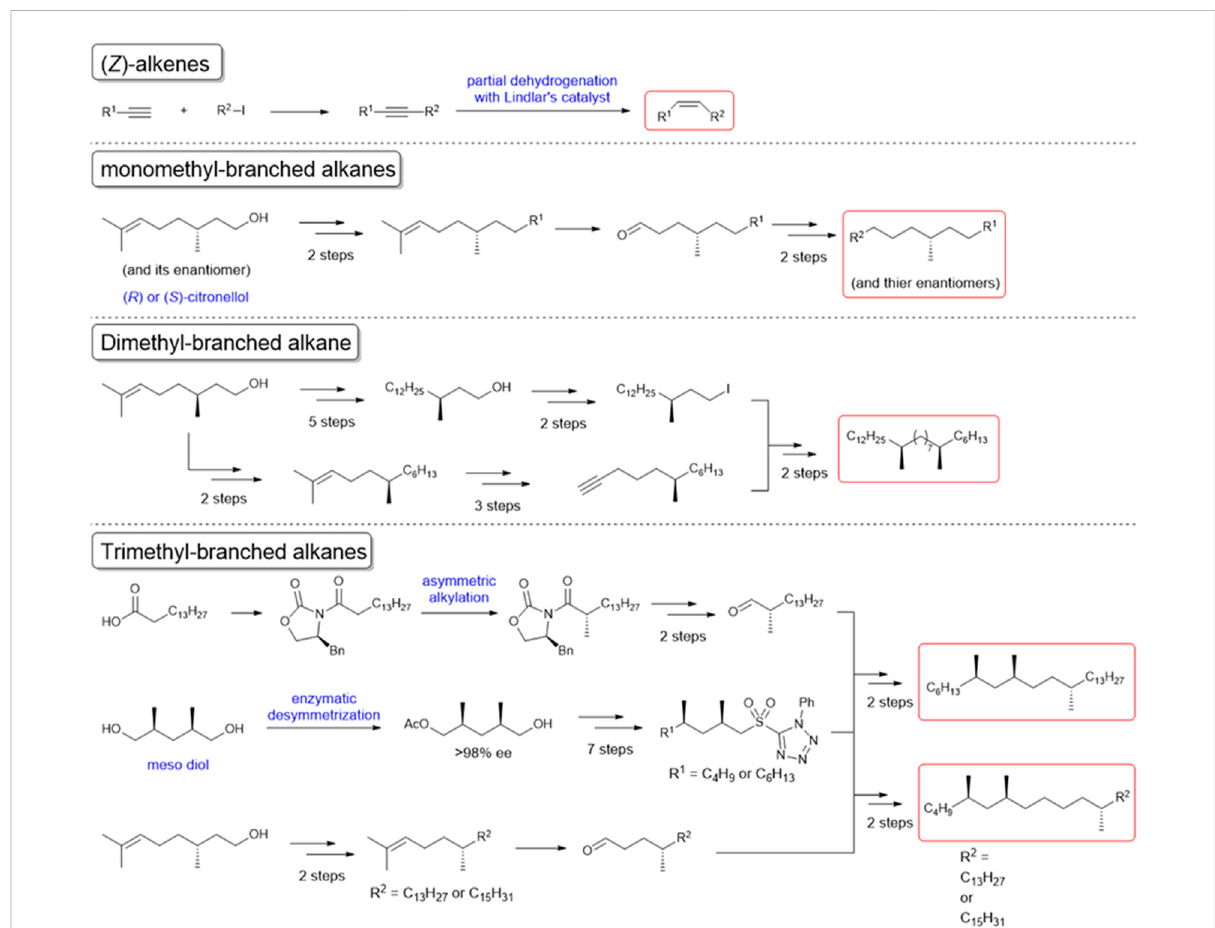
worker L. humile to C. Japonicus whole CHC extract, classifying three behaviors: ignore (blue), avoidance (yellow), and aversion (red) (see Supplementary Movies S3 − S5). At lower doses the